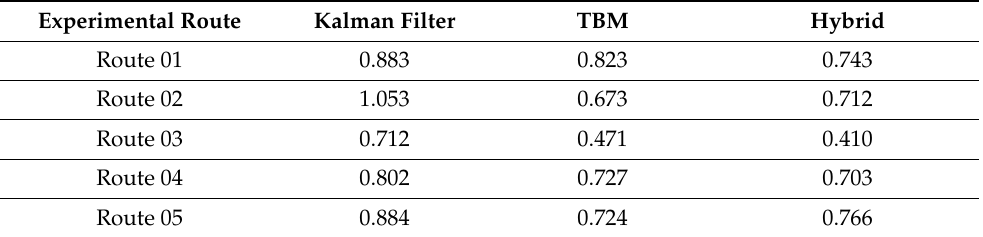
Table 7. The Maximum Allowable Moving Speed (m/sec) of Routes